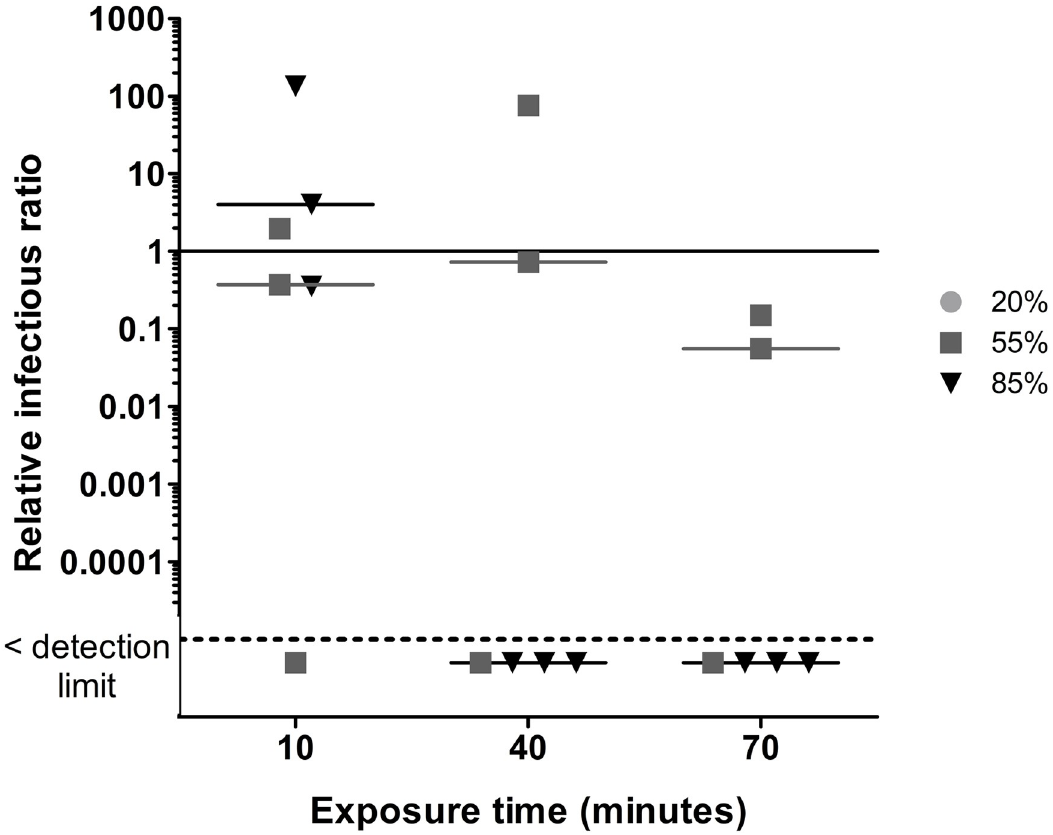
Fig 6. Ozone effect on phage φ 6 infectivity at three levels of relative humidity and three exposure times. The solid line represents the reference value without ozone. The dotted line represents the detection limit. 20% RH values are represented by circles ( ● ), 55% RH by squares ( ■ ) and 85% RH by triangles ( ▼ ).